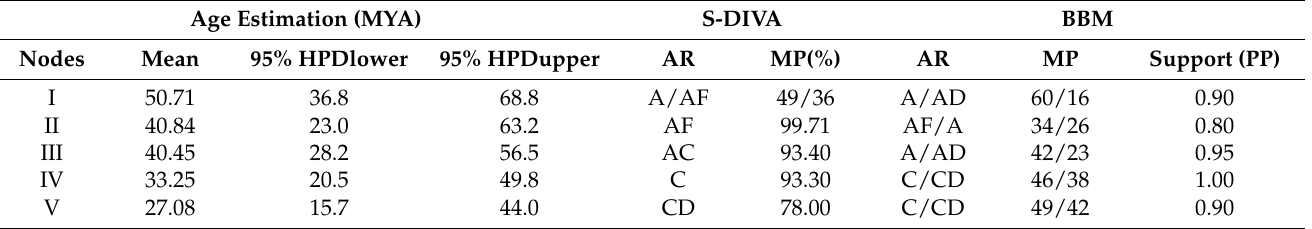
Table 2. Age estimation in million year ago (MYA) of nodes of divergence time clade based on S-DIVA and BBM.